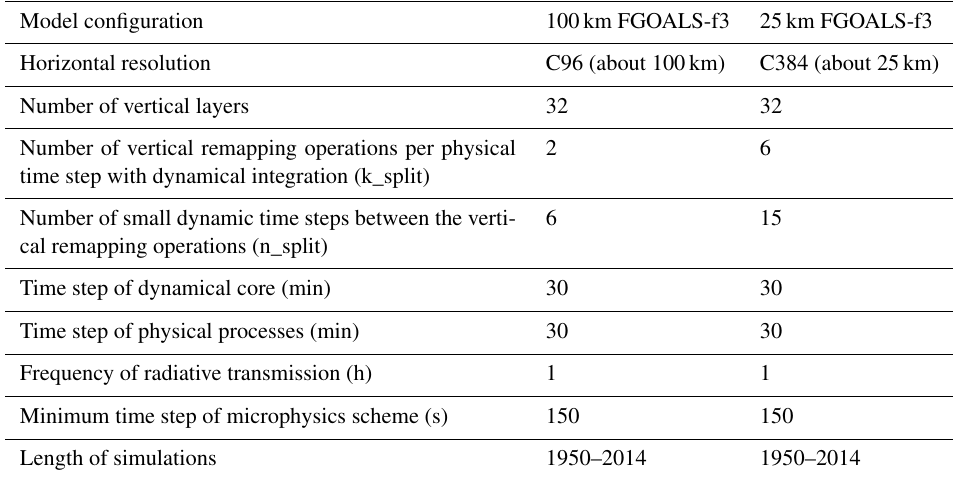
Table 2. Comparison of resolutions, time steps and length of simulations in FGOALS-f3 for HighResMIP Tier 1. Model configuration